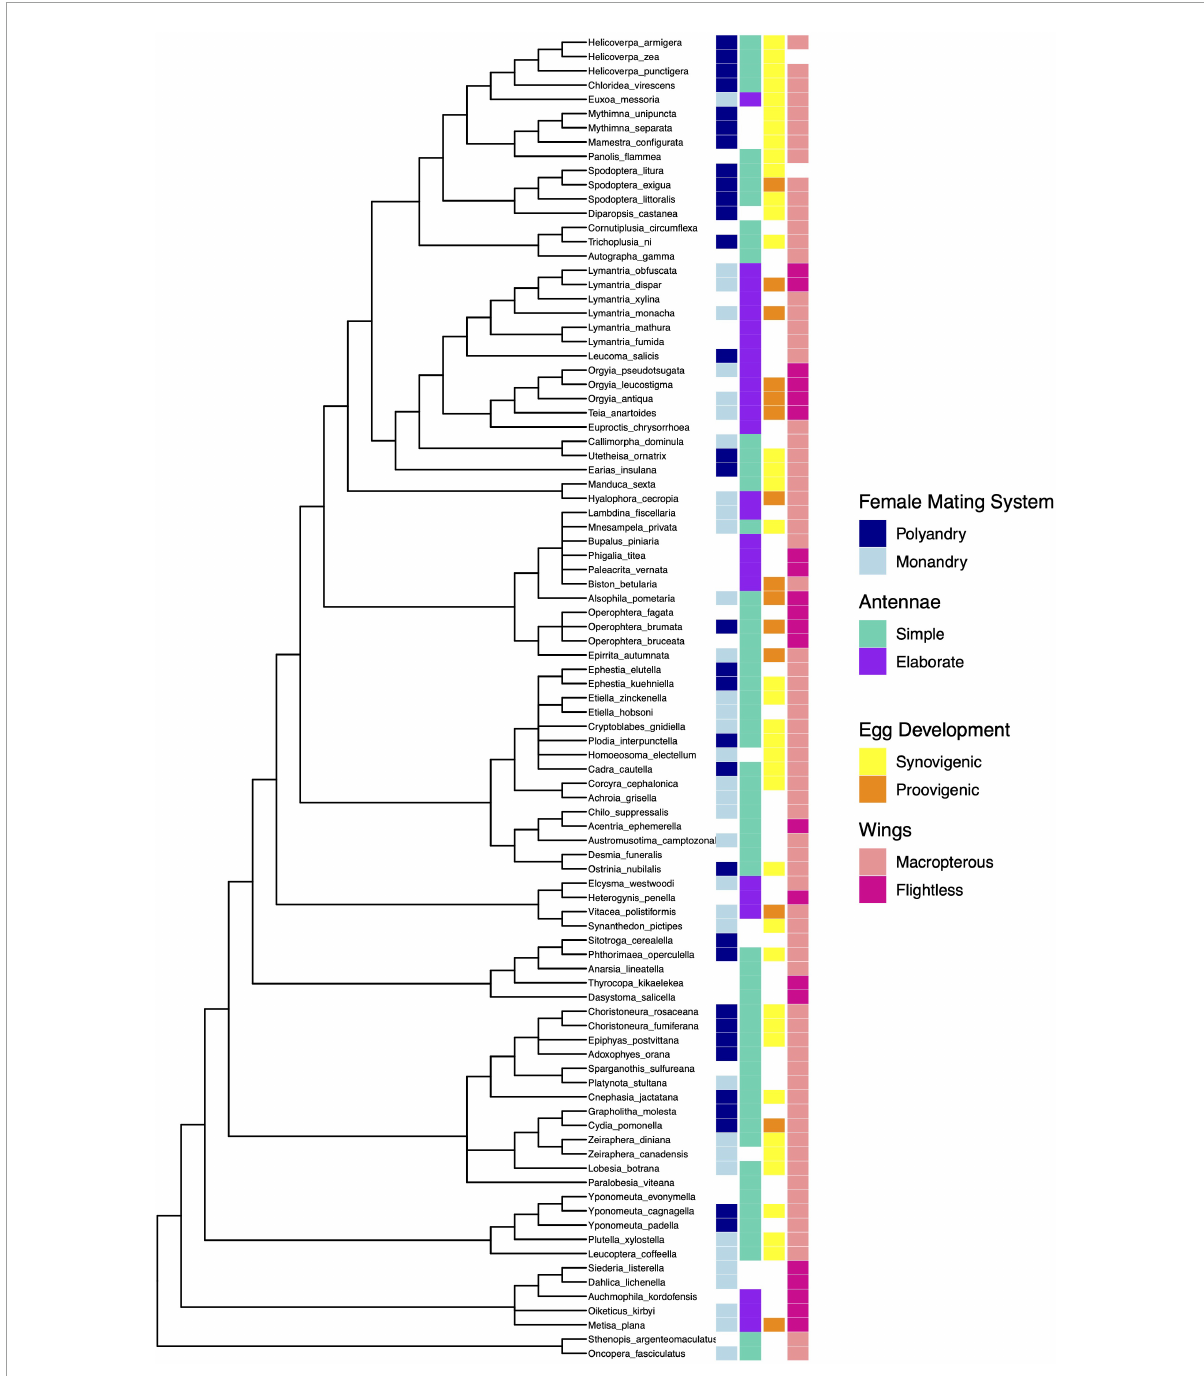
FIGURE1 Composite phylogeny of the moth species used in the analysis, with character states of categorical traits indicated (missing blocks indicate the character state was unknown). Branch lengths are for illustrative purposes only, and do not represent the lengths used for analysis.